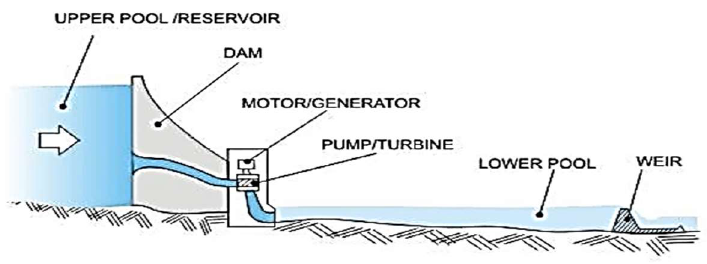
Figure 5. Pumped storage scheme [56].